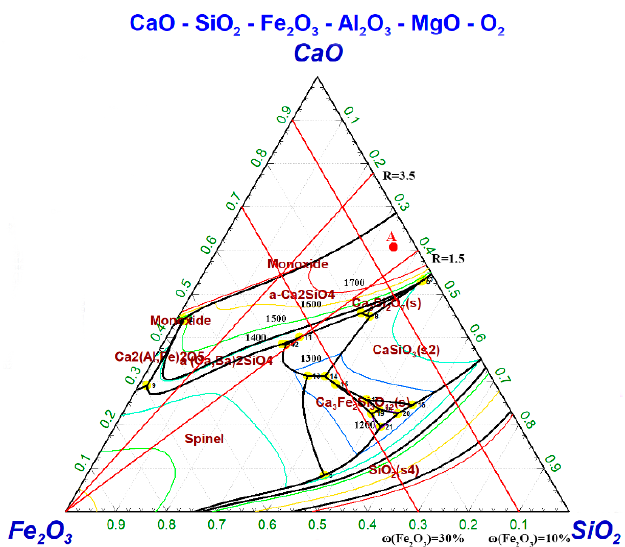
Figure 4. Pseudo-pentad phase diagram of CaO–SiO 2 –Fe 2 O 3 –2.5%MgO–1%Al 2 O 3 .